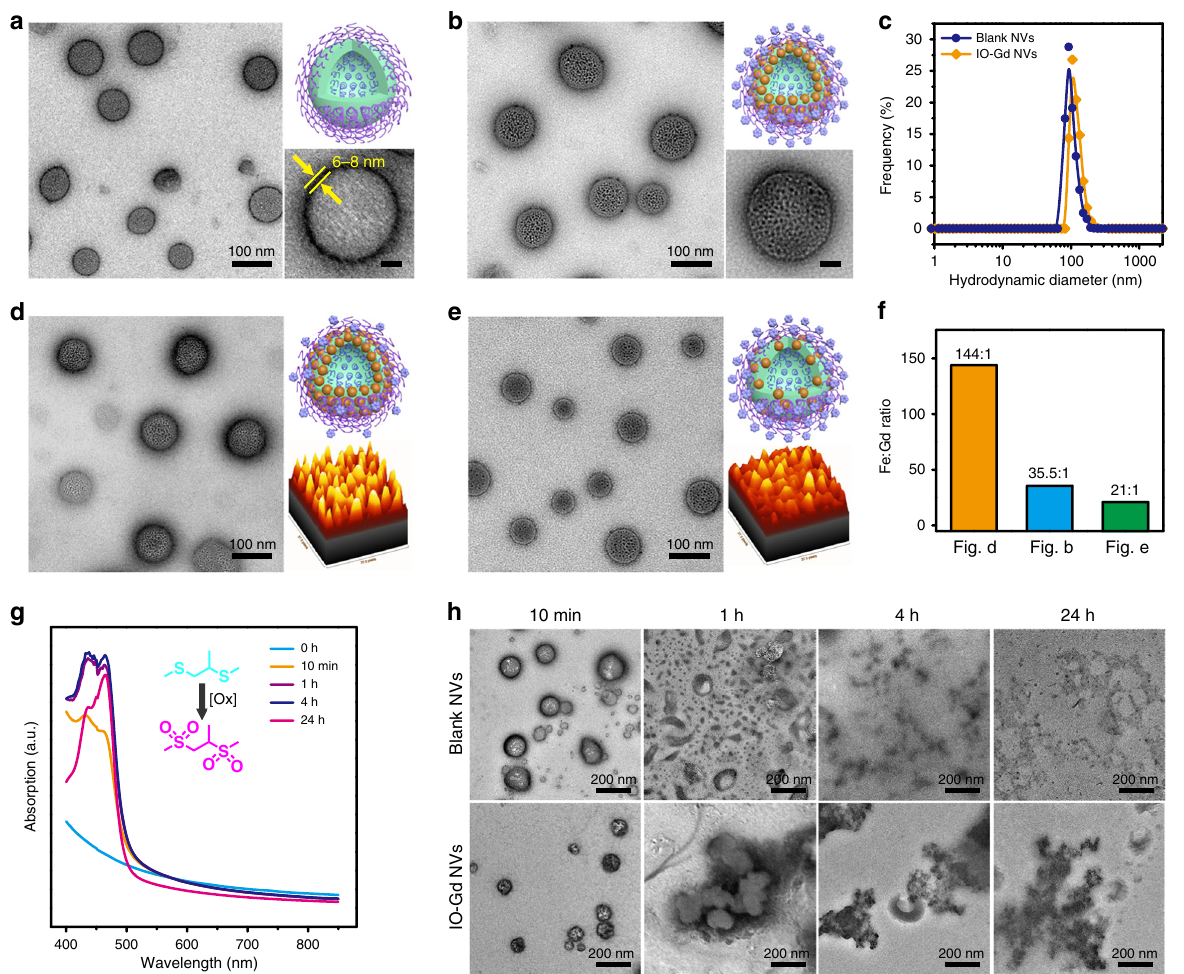
Fig. 2 Characterizations of ROS-responsive IO-Gd NVs. a TEM image, cartoon image (upper right), and magni fi ed TEM image (lower right, scale bar 20 nm) of the blank NVs. The membrane thickness of the blank NVs is about 6 – 8 nm. b TEM image, cartoon image (upper right), and magni fi ed TEM image (lower right, scale bar 20 nm) of the IO-Gd NVs (Fe:Gd = 35.5:1). c DLS measurements of the blank NVs and the IO-Gd NVs. d – f TEM images and column analysis of the IO-Gd NVs with different Fe:Gd molar ratios. Insets show the cartoon fi gure and intensity-based analysis of the distribution of IO NPs according to the TEM image, respectively. g Time-dependent UV – vis absorption of the blank NVs incubated with NaCl, MPO (5 U/mL), and H 2 O 2 (500 μ M). h TEM images of the blank NVs and the IO-Gd NVs incubated with NaCl, MPO (5 U/mL), and H 2 O 2 (500 μ M) at different time